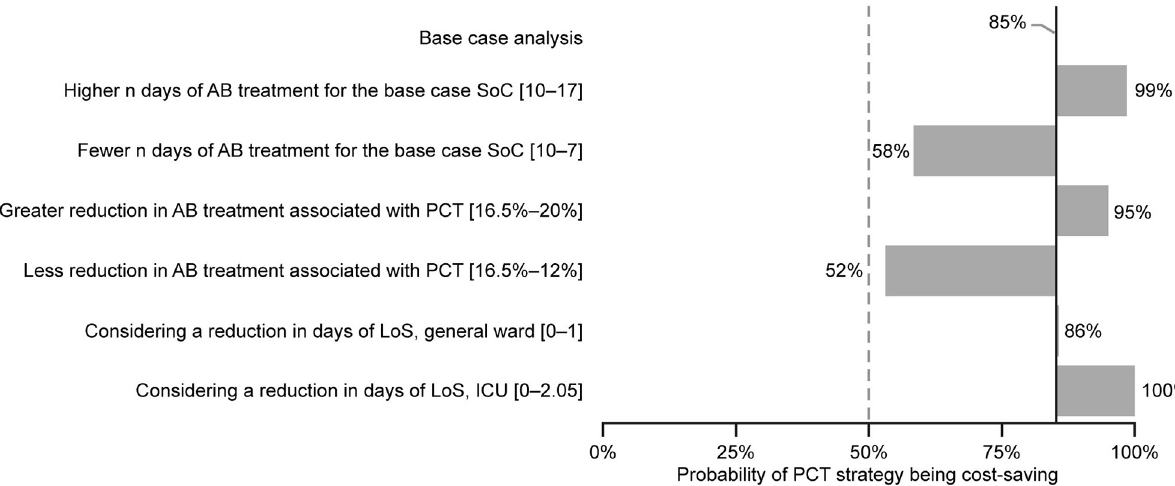
Fig 3. Scenario analysis. Probability of saving costs for PCT strategy according to different scenarios. Argentina, 2020. AB, antibiotic; ICU, intensive care unit; LoS, length of stay; n, number; PCT, procalcitonin; SoC, standard of care.